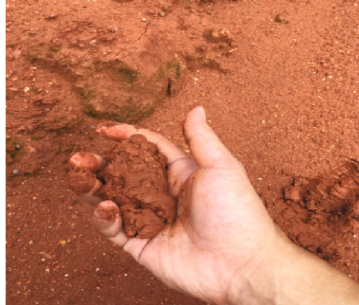
Figure 3: Environment of the drilled soil for